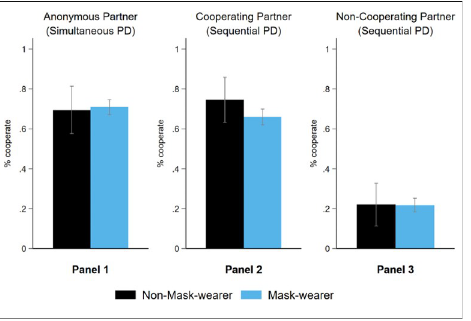
Fig 2. Average cooperation levels in PD games before mask usage elicitation. 4-standard-error bars (2 above, 2 below) to represent 95% confidence intervals.